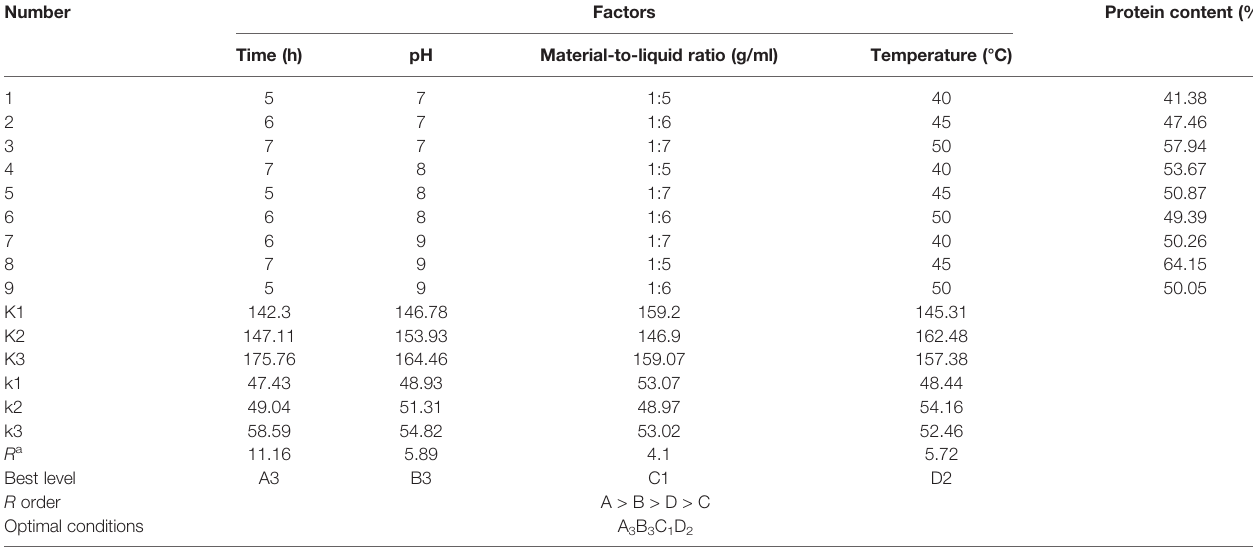
TABLE 1 | Orthogonal array design matrix L 9 (3 4 ) and experimental results for optimizing gelatin extraction conditions from Siberian sturgeon cartilage.